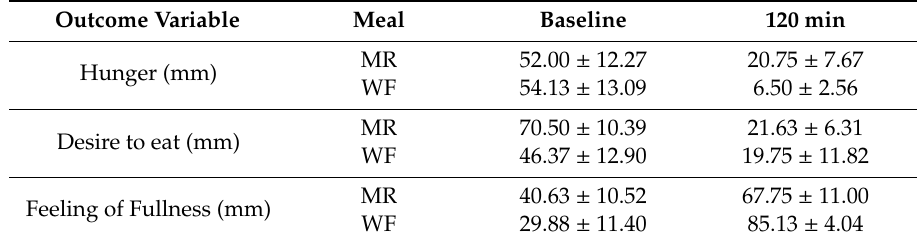
Table 6. Effects of meal type on mean values of hunger and satiety rating outcome measurements at baseline and 120 min in the postprandial period a .